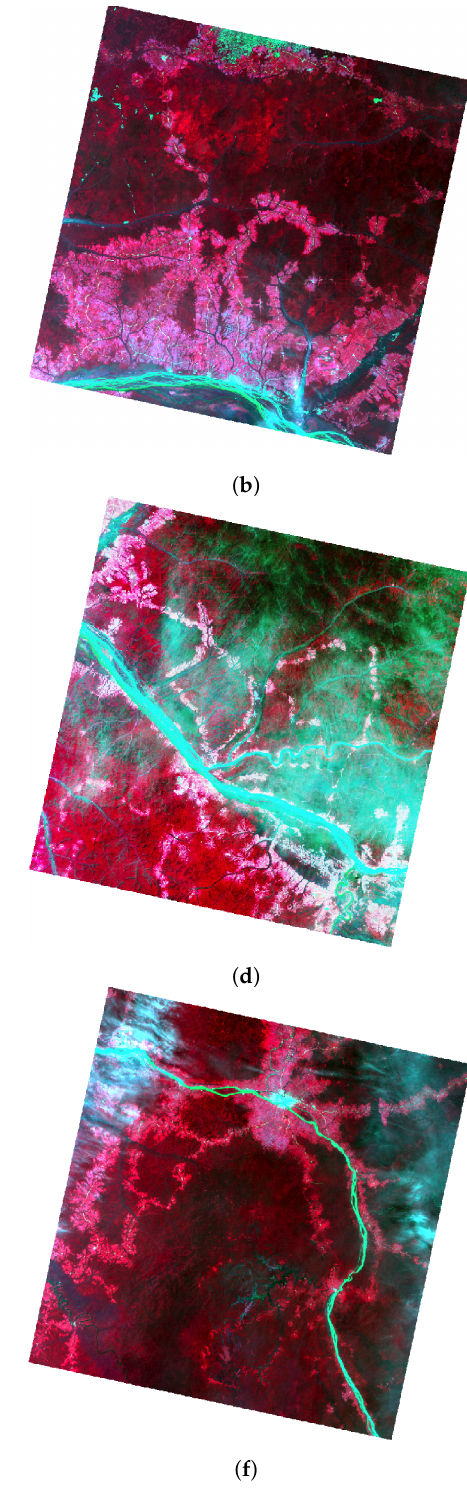
Figure 5. Natural (bands 4-3-2) and false colour (bands 5-4-3) composites of the Landsat 8 OLI / TIRS image for the three target areas: Bumba, Basoko and Kisangani. Mapping: RStudio. ( a ) Bumba: natural colour composite, 2013. ( b ) Bumba: false colour composite: 2013. ( c ) Basoko: natural colour composite: 2013. ( d ) Basoko: false colour composite: 2013. ( e ) Kisangani: Natural colour composite: 2013. ( f ) Kisangani: False colour composite: